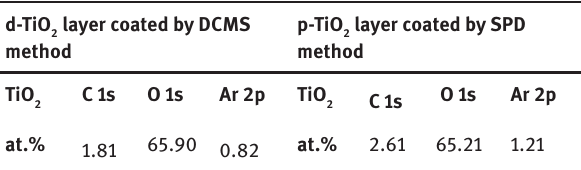
Fig 6. SEM images of bilayer TiO films (a) 1000 KX (b) 300 KX (c) 100 KX Figure 3. XRD patterns of ITO crystal structure are 21˚, 30˚, 2 35˚, 37˚, 45˚ and 49˚ with regard to (211), (222), (400), (411), (431) and (440) from (hkl) planes of ITO, respectively [33] .